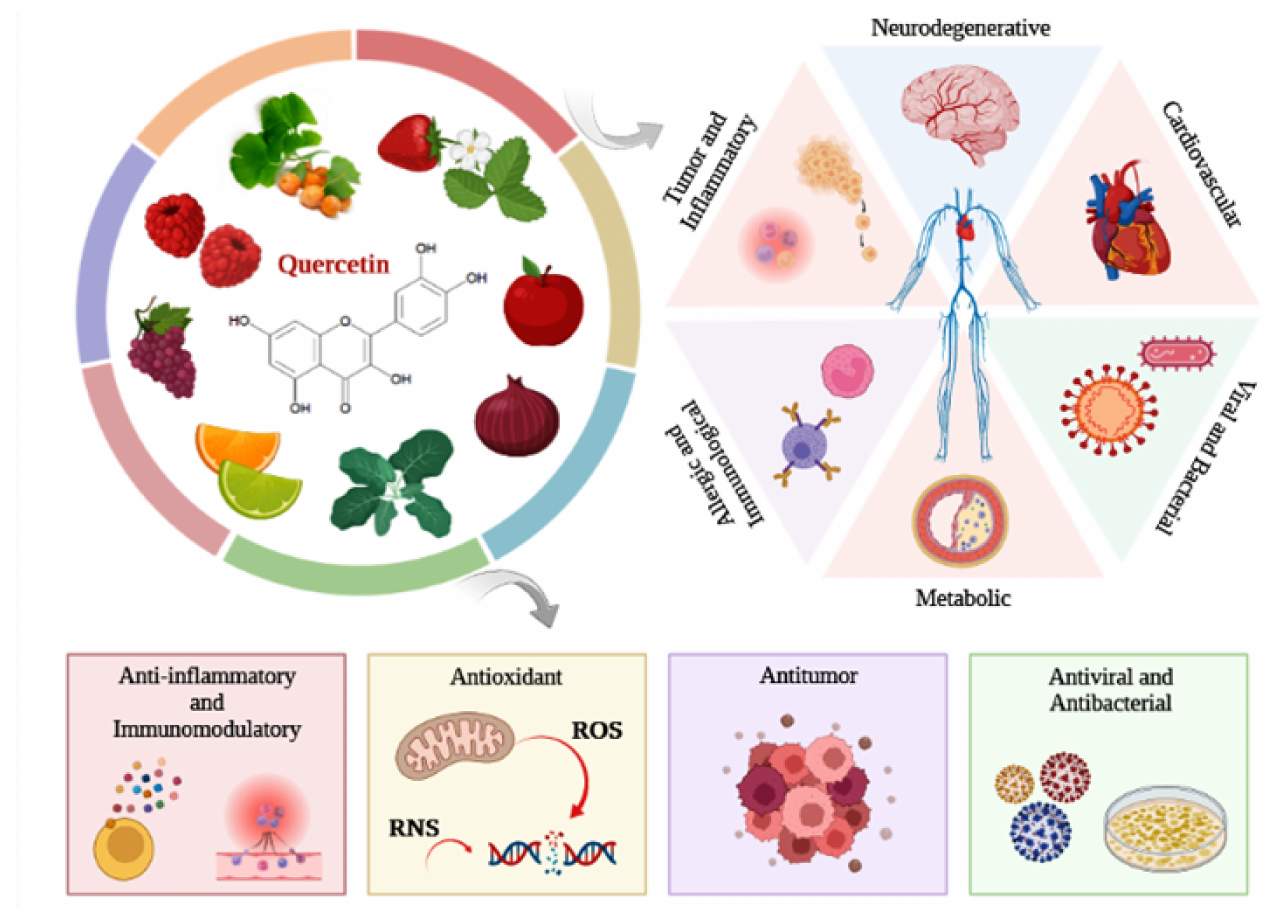
Figure 2. Quercetin is a dietary flavonoid widely distributed among a diversity of fruits, vegetables, and medicinal plants. Quercetin has anti-inflammatory, antioxidant, antitumor, antiviral, antibacterial, and neuroprotective properties. Due to its properties, quercetin can exert beneficial biological activity, acting in the prevention of various pathologies, such as cancer, bacterial and viral infections, cardiovascular, neurodegenerative, inflammatory, immunological, and metabolic diseases. Reactive Nitrogen Species